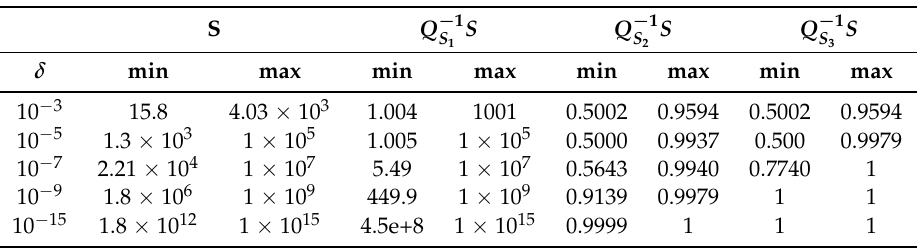
Table 2. Maximum and minimum eigenvalues for the Schur complement S and preconditioned Schur complement with preconditioners Q S